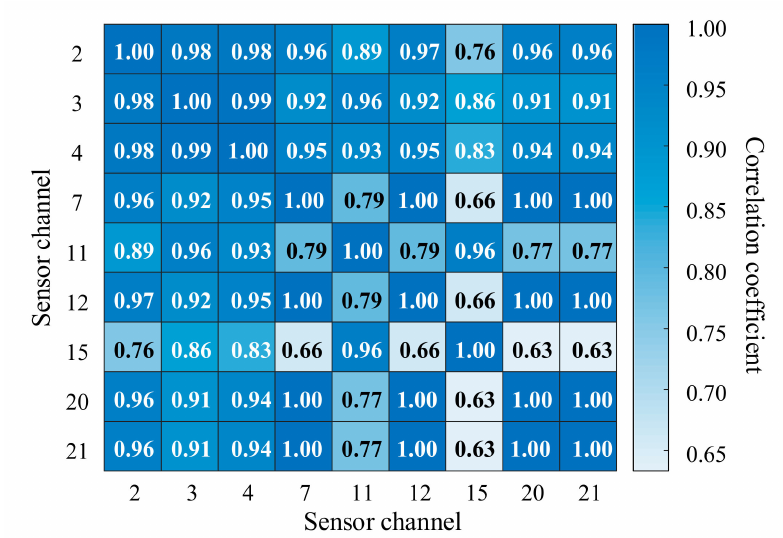
Figure 3. Correlation coefficient between the monitoring data of each